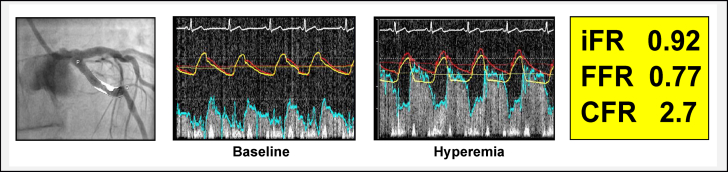
FFR+/iFR– Discordance Attributed to High CFR: Clinical CaseThe coronary angiogram image displays a proximal circumflex stenosis. Quantitative coronary angiography derived percentage diameter stenosis, area stenosis, and minimal lumen diameter were 62%, 85%, and 1.20 mm, respectively. Invasive pressure-based coronary physiology assessment revealed discordant iFR (negative) and FFR (positive) results. Upon measuring combined coronary pressure-and-flow data, the FFR+/iFR– discordant result can be attributed to high CFR. Abbreviations as in Figure 1.